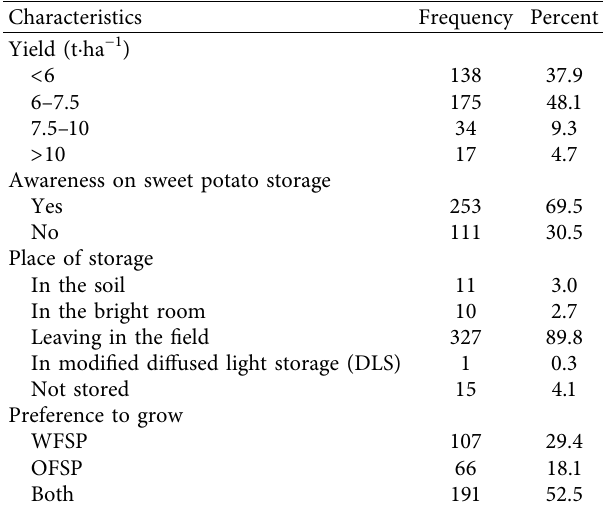
Table 4: Yield and postharvest management of orange-fleshed sweet